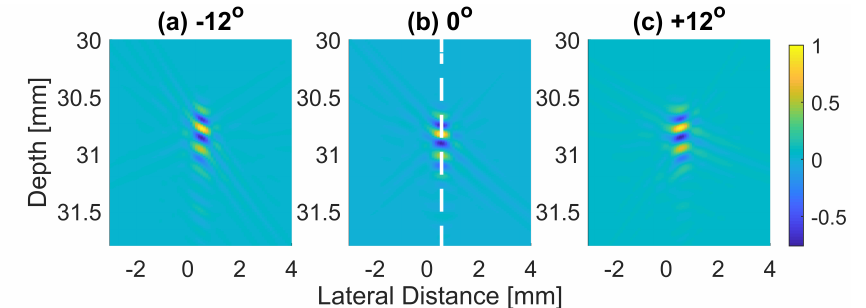
Figure 2. Normalized pressure fields at the position of the dashed line as shown in Figure 1 for plane waves steered at − 12 ◦ , 0 ◦ and + 12 ◦ . The pressure fields for steering angles − 12 ◦ and + 12 ◦ overlap with each other.